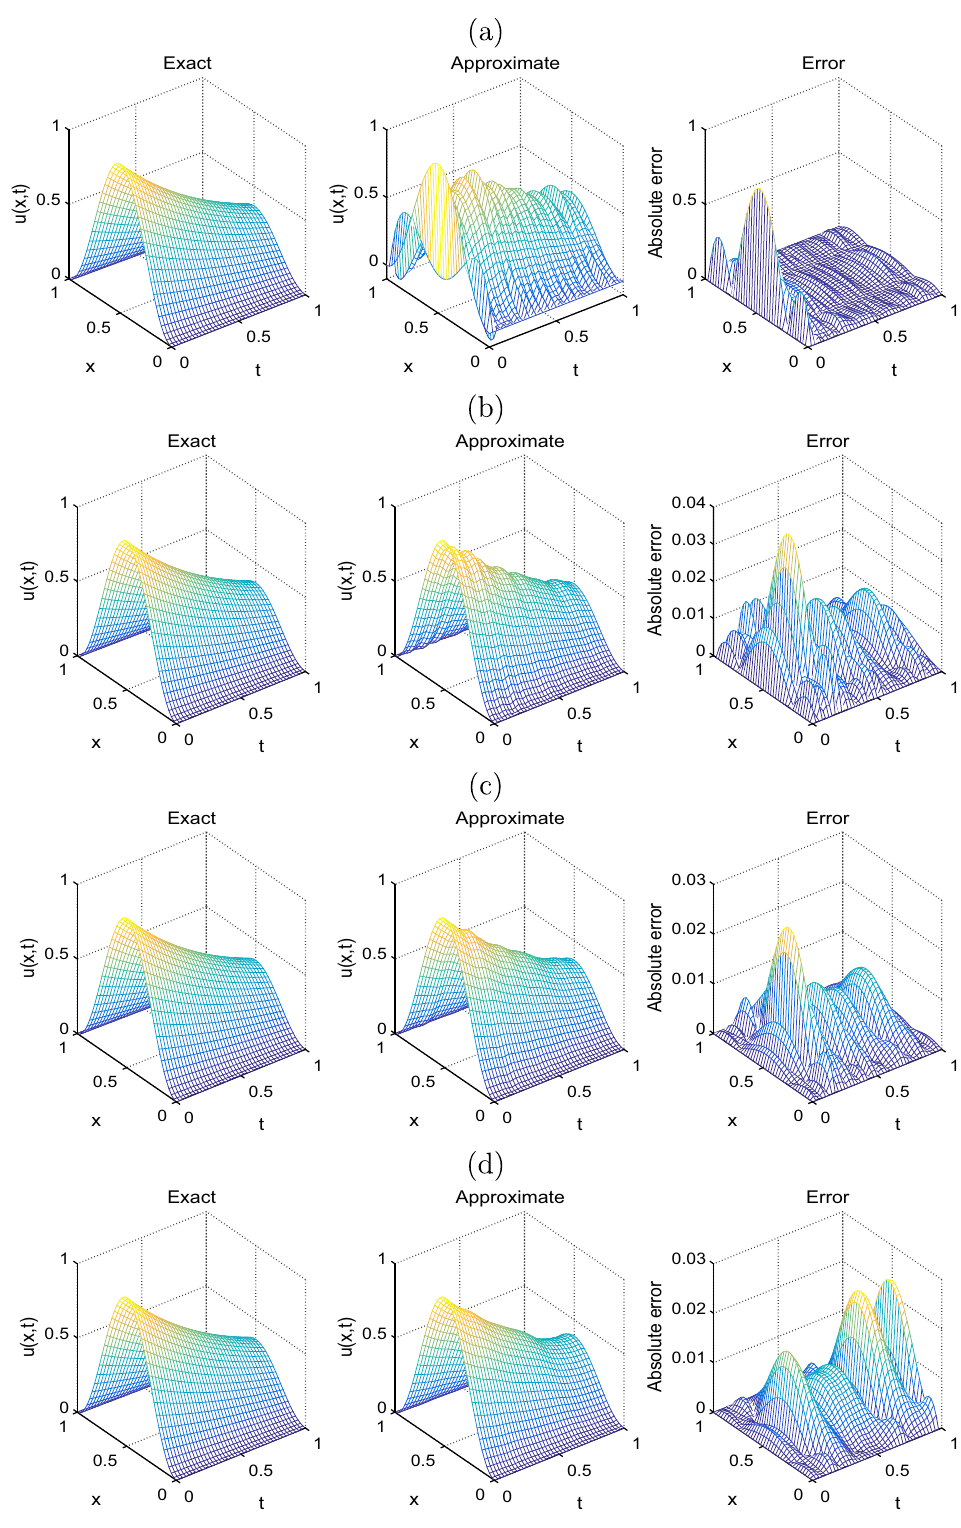
Figure 10: The exact ( 88 ) and approximate ( ) u x t , , and absolute errors with = p 1% and λ ( a ) 0, ( b ) 10 −6 , ( c ) 10 −5 , and ( d ) 10 −4 , for Example